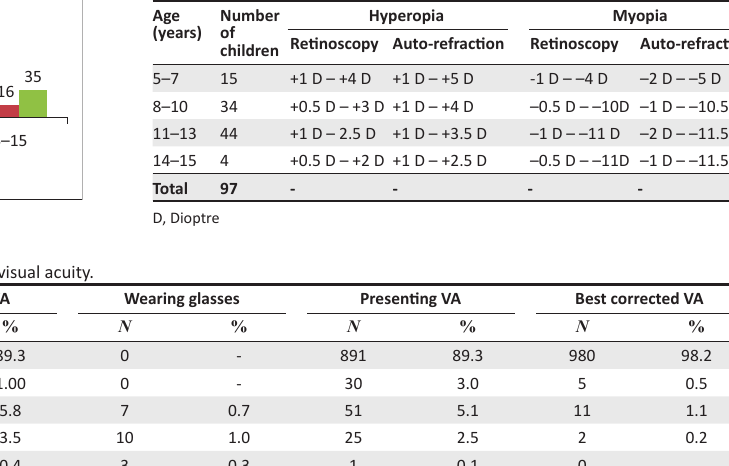
TABLE 2: Retinoscopy and